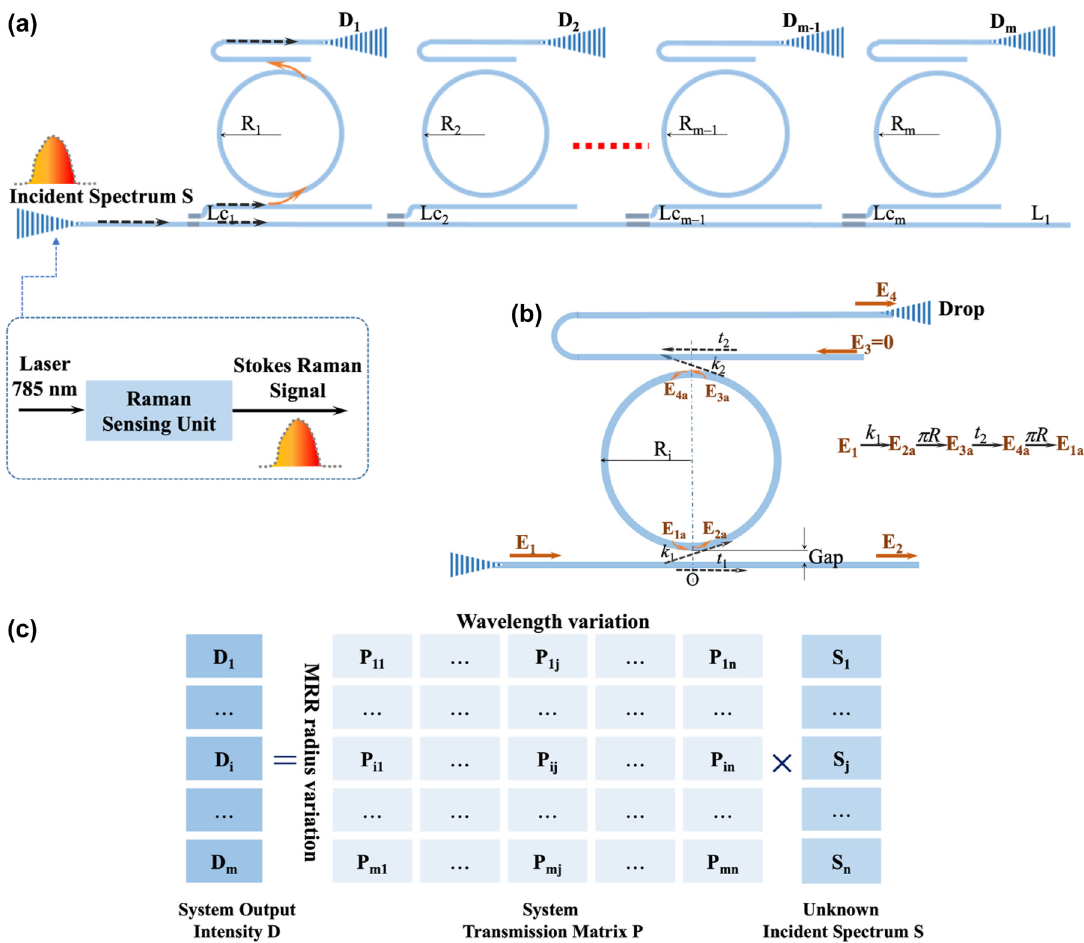
Figure 1: Schematic diagram of (a) micro-ring resonator array spectrum detection system and L micro-ring resonator. (c) System matrix equation constructed by micro-ring resonator array. Note that the incident spectrum S comes a Raman sensing unit by an excitation light of 785 nm laser, so the operating wavelength range of the spectrum detection system is ∼ 800